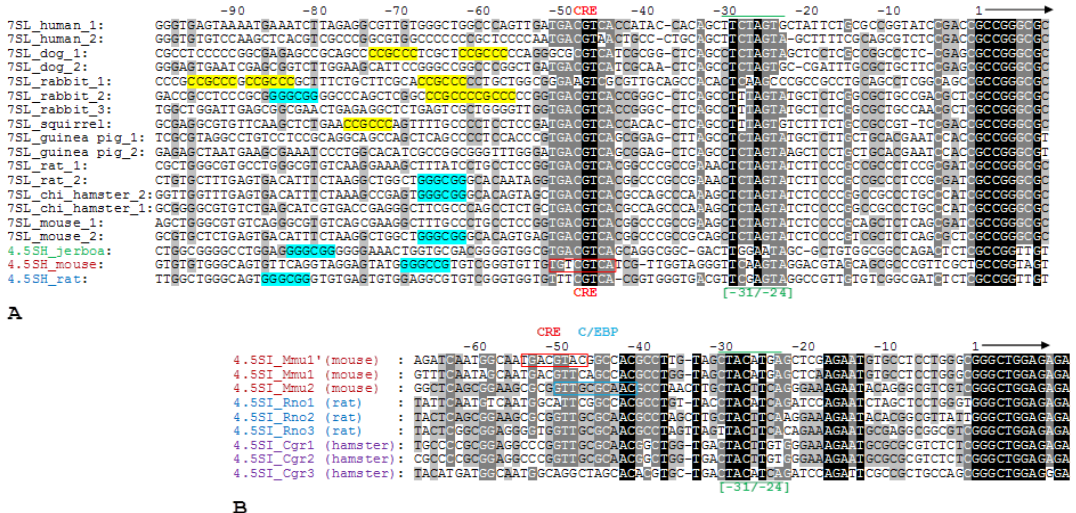
Figure 2. 5 ′ -FSs of 4.5SH RNA, 7SL RNA, and 4.5SI RNA genes from the genomes of different species. ( A ) 5 ′ -FSs of 4.5SH RNA genes of rat, mouse, and jerboa are aligned with 5 ′ -FSs of 7SL RNA genes of the mouse, Chinese hamster, rat, Guinea pig, squirrel, rabbit, dog, and human (in most cases two variants of 7SL RNA gene are showed). Two conserved regions correspond to the TATA-like box (–31/–24) and CRE (–51/–44). CRE in 5 ′ -FS of mouse 4.5SH RNA gene is boxed. Opposite orientations of Sp1 recognition sites are highlighted in blue and yellow. ( B ) Alignment of 5 ′ -FSs of three 4.5SI RNA gene variants from the genomes of mouse, rat, and Chinese hamster. The TATA-like box (–31/– 24) is marked by lines above and below the alignment. The octamer similar to CRE in Mmu1 ′ gene is boxed in red. The C/EBP recognition site in Mmu2 gene is shown in a blue frame.